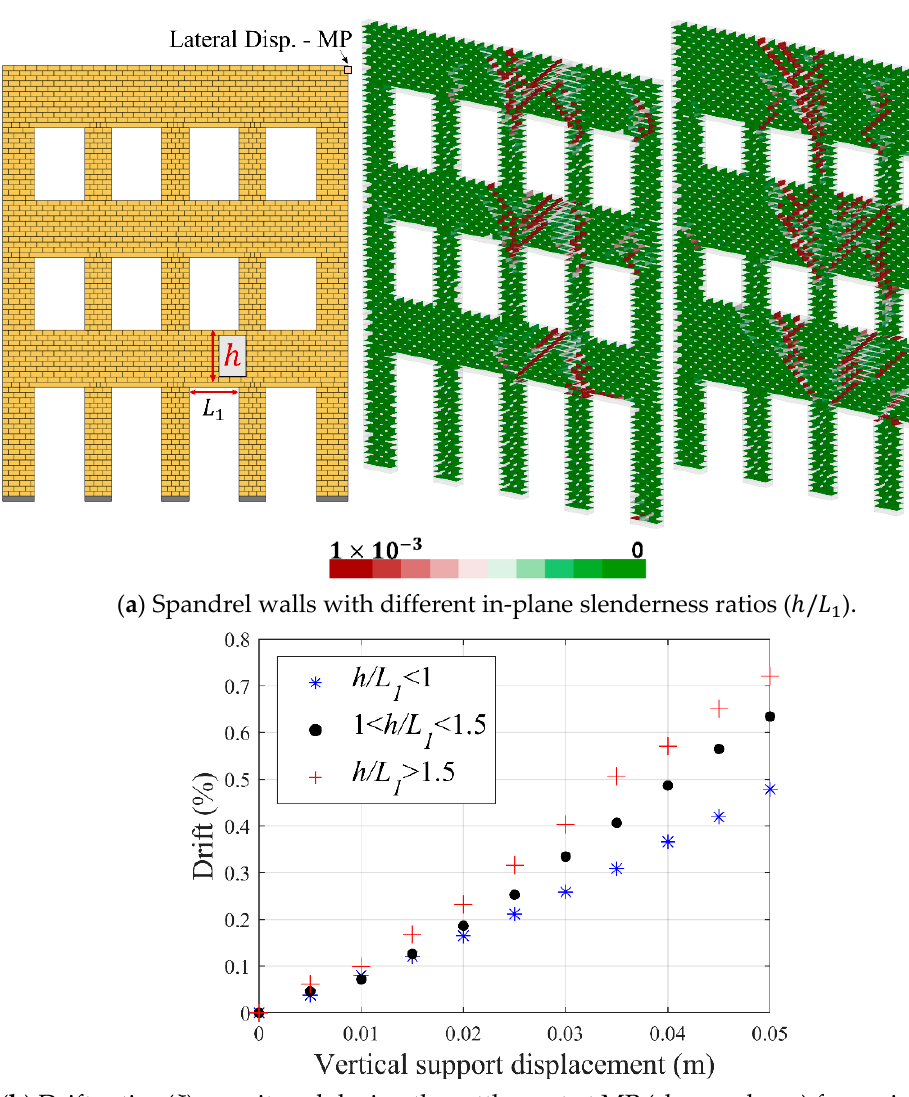
( b ) Drift ratios ( 𝜉 ), monitored during the settlement at MP (shown above) for various in ‐ plane slenderness ratios of spandrel walls. Figure 9. Damage response of URM Façade with different slenderness ratios of spandrel walls: Crack pattern ( ∆𝑢 (cid:3040)(cid:3028)(cid:3051) = 0.05 m) and drift ratios.